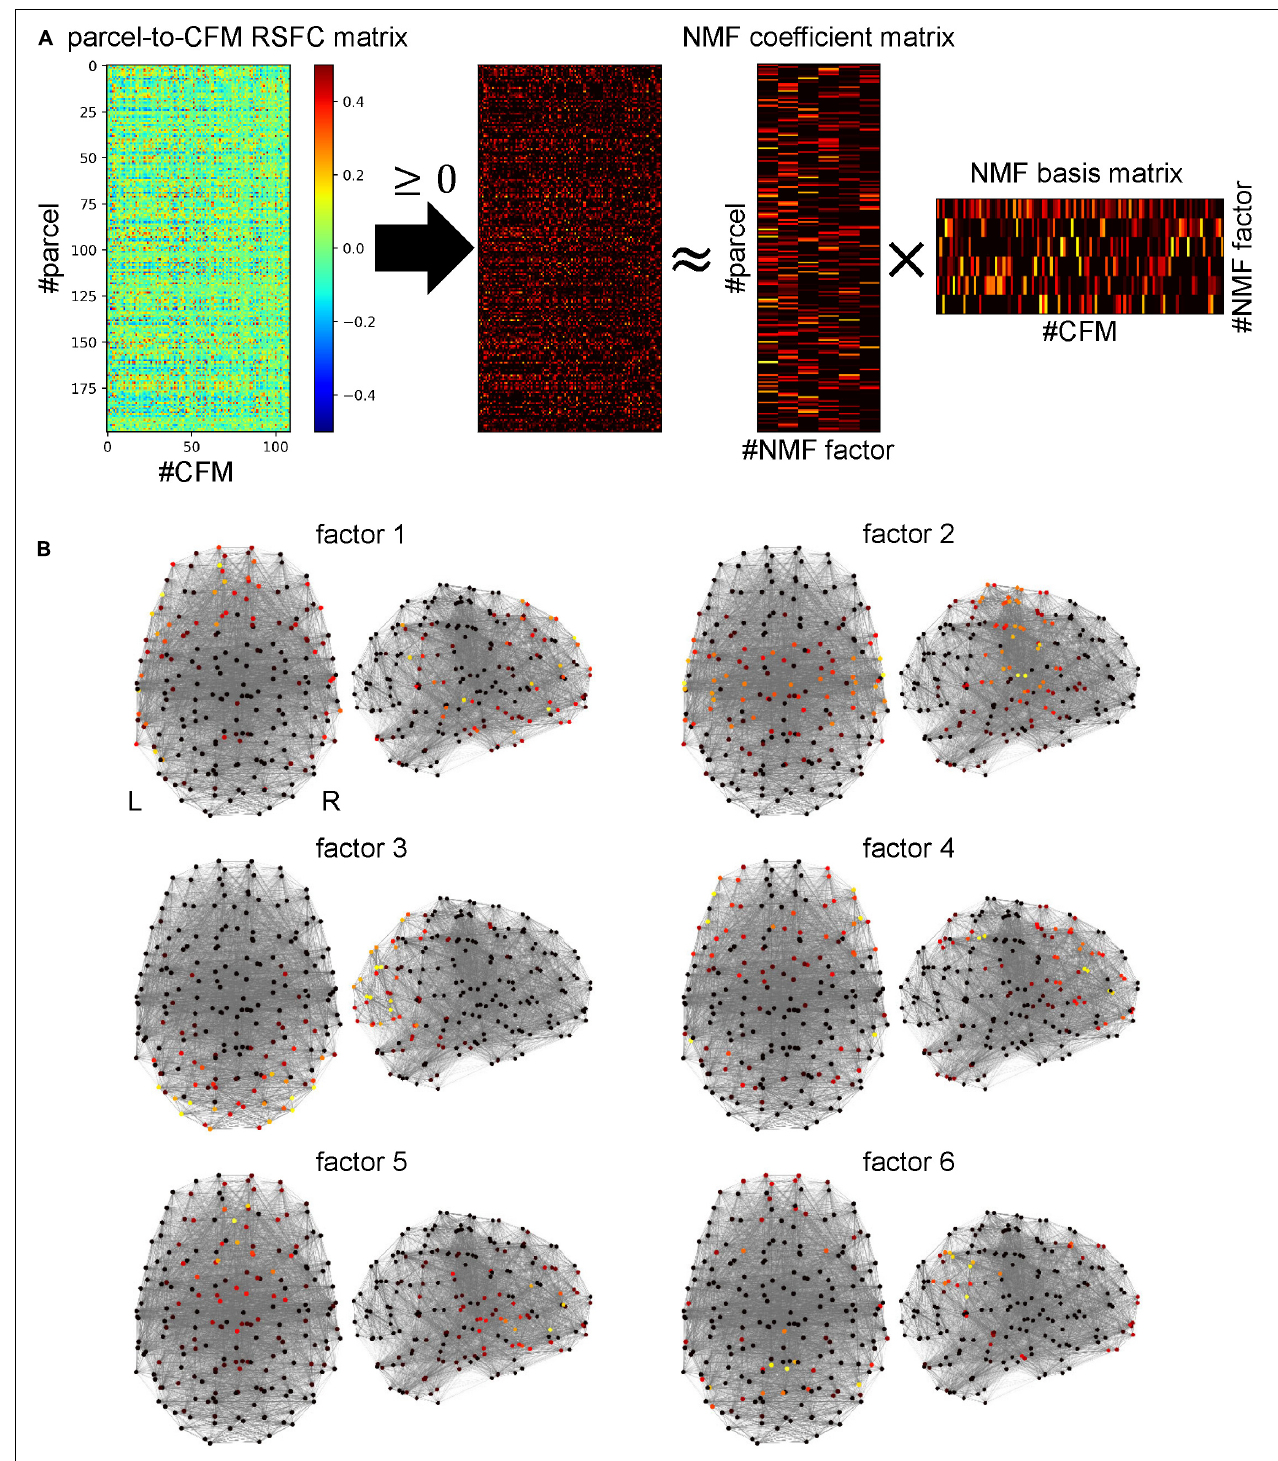
FIGURE 5 | Identifying cognitive factors using non-negative matrix factorization (NMF). (A) Procedure for identification of cognitive factors. First, the parcel-to-cognitive function map (CFM) resting-state functional connectivity matrix was thresholded with zero. Then, NMF was applied to the thresholded matrix, and the NMF coefficient and basis matrices were identified. The rows and columns of the NMF coefficient matrix correspond to parcels and NMF factors (cognitive factors), respectively. The rows and columns of the NMF basis matrix correspond to factors and CFMs, respectively. (B) The NMF coefficient values for each NMF factor are mapped on the parcels (shown as dots) located according to coordinates on a standard brain using heat mapping.